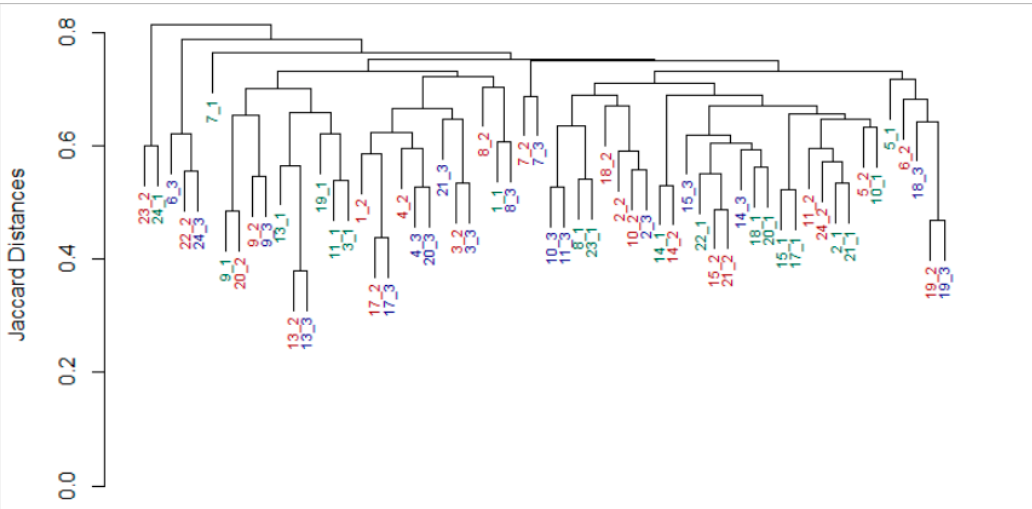
Figure 4. Subject identity in infant stool microbiome. Dendrogram based on nearest neighbor joining of samples according to the Jaccard distance matrix of stool microbiome samples. Leaf labels show Subject ID and the time the sample was collected (green_week postpartum, red_one month postpartum, blue_three months postpartum). ANOSIM: p = 0.001, R = 56%. * No data were available for participants number 12 and 16.